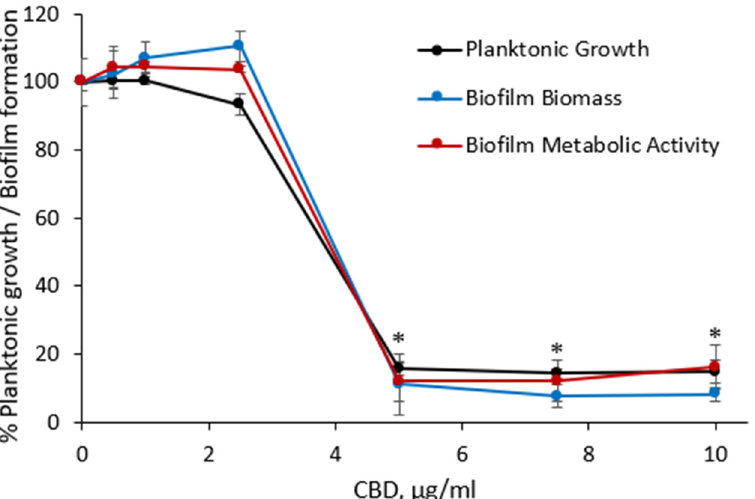
Figure 2. Anti-bacterial and anti-biofilm effect of CBD on S. mutans . The bacteria were exposed to increasing concentrations of CBD for 24 h. The bacterial growth was measured at an optical density (OD) of 595 nm. The biofilm biomass was quantified by CV staining and the biofilm metabolic activity determined by the MTT assay. The average and SEM from a representative experiment are presented. * p < 0.05 in comparison to the control.